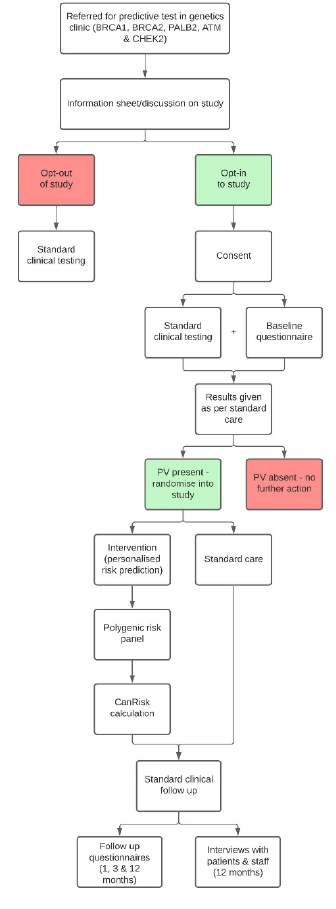
Figure 1. Overview of the study design.